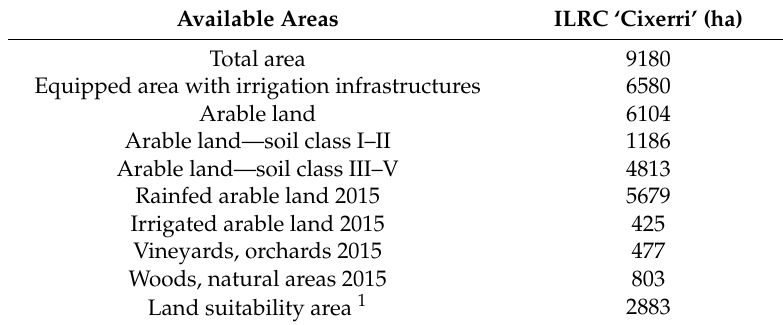
Table 3. Available land, soil class units, land use/cover and suitable land areas for biomass production across the ILRC